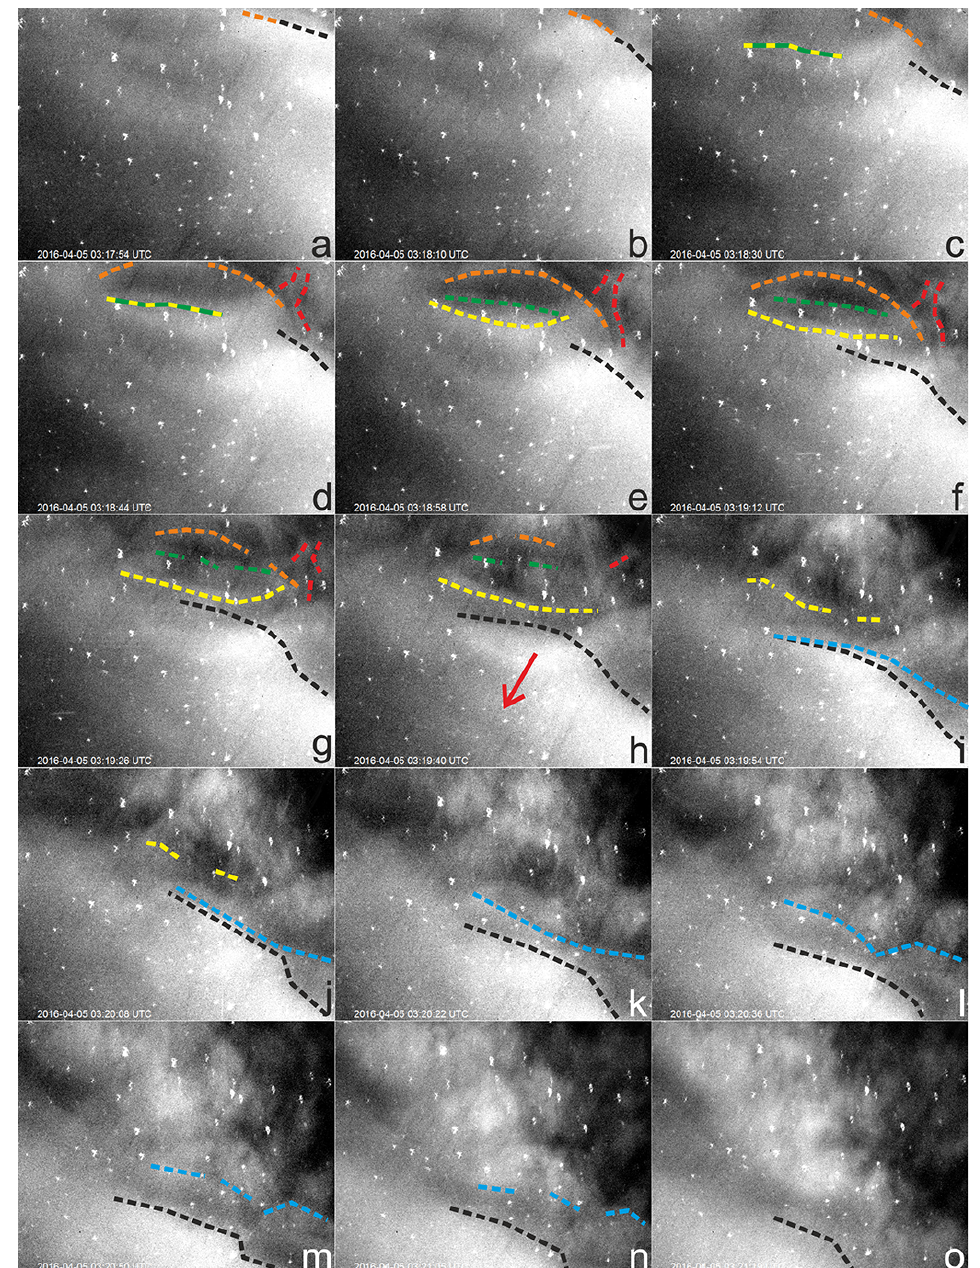
Figure 6. Image series of the second case study (5 April 2016 between 03:17:54 and 03:21:19UTC). A wave front, indicated by the dashed black line, propagates into the direction the red arrow in (h) is indicating. While it continues propagating to the lower left, a filament separates from it on the left side ( a , b , orange). At 03:18:30UTC (c) a second filament structure becomes visible below the first filament. In the further course of the image series ( e , f ) it turns out to separate into two structures, one filament moving downward (yellow) and one stationary filament (green). At 03:19:26UTC (g) the orange and the green structure begin to dissolve. The yellow structure continues propagating for a few more seconds and finally also starts decomposing at 03:19:54UTC (i) . At 03:18:44UTC (d) two more filaments form at the upper right of the FOV right behind the initial wave front and are, in contrast to the other filaments, aligned perpendicular to it. They decompose at 03:19:26UTC (g) . While the dynamics of the filaments take their course and form a vortex, rotating around a horizontally oriented axis, the initial wave front (black) overtakes the other structures, retaining its original direction (indicated by the red arrow in h ). At about 03:19:54UTC (i) another filament (blue) separates from it. This new filament remains stationary and starts decaying at 03:20:50UTC (m) . The wave front (black) keeps on propagating and leaves the FOV toward the lower left. The entire sequence is shown in Video 2 in the